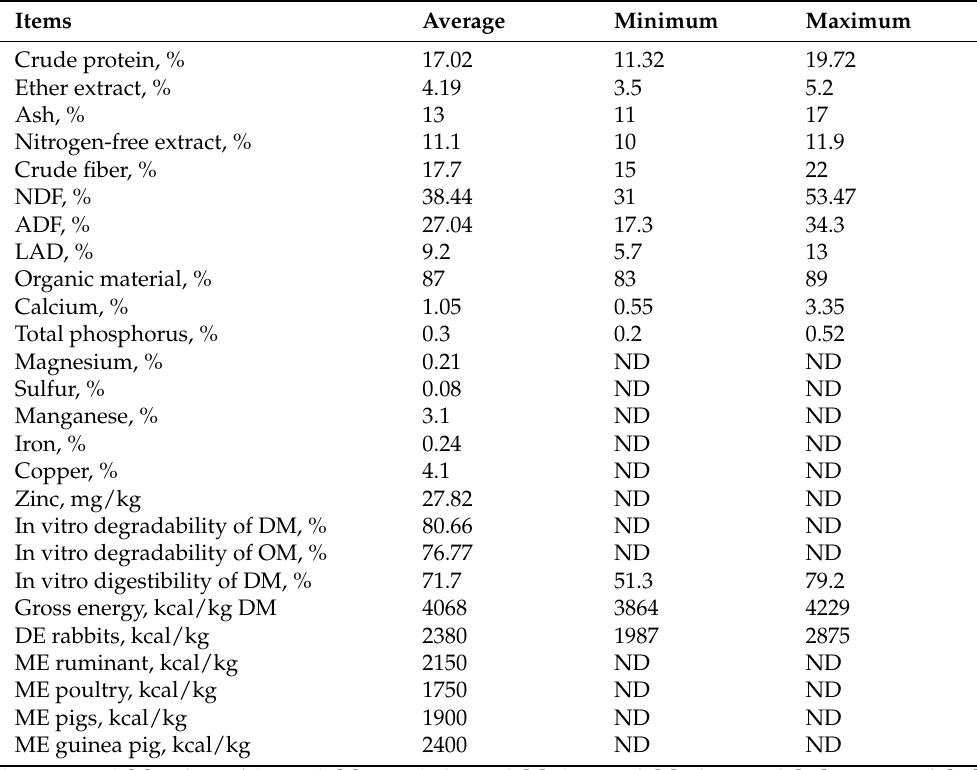
Table 4. Chemical composition of forage meal (leaves + petioles + stems) on a dry basis (100% DM). Items Average Minimum Crude protein, % Ether extract, % Ash, % Nitrogen-free extract, %